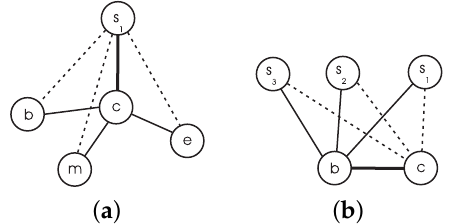
Figure 4. Examples of the word of mouth model ( a , b ). s i ∈ V s and { b , c , e , m } ∈ V . Highlighted links indicate the edges that have just been added to the network, straight lines are edges inserted in the previous steps, and dashed ones represent the possible options for new links (and that have a higher probability to be